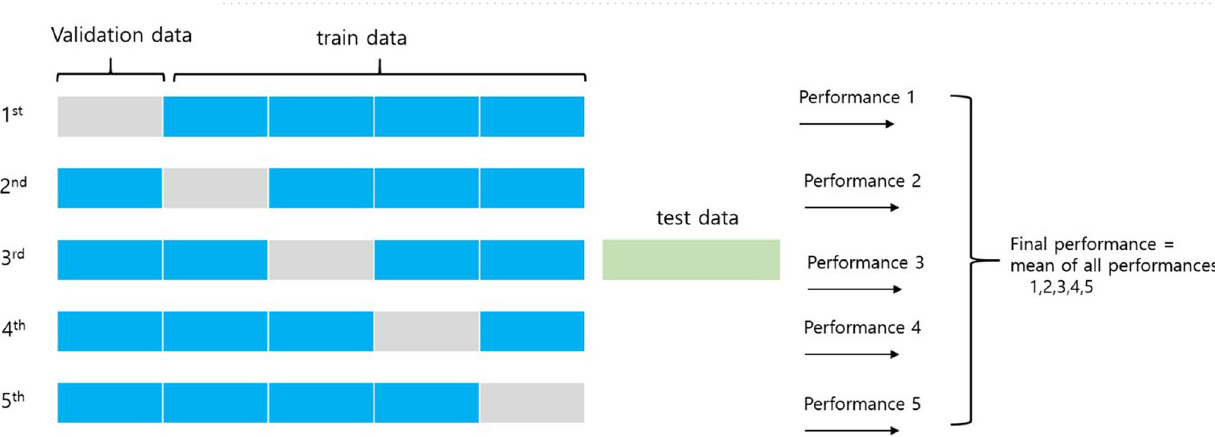
Figure 8. VGG16 architecture for our model. The input size for our model is 256 × 256. We freeze all layers in VGG16 without fully-connected layer, and with extracting features, we classified the respiratory sounds.